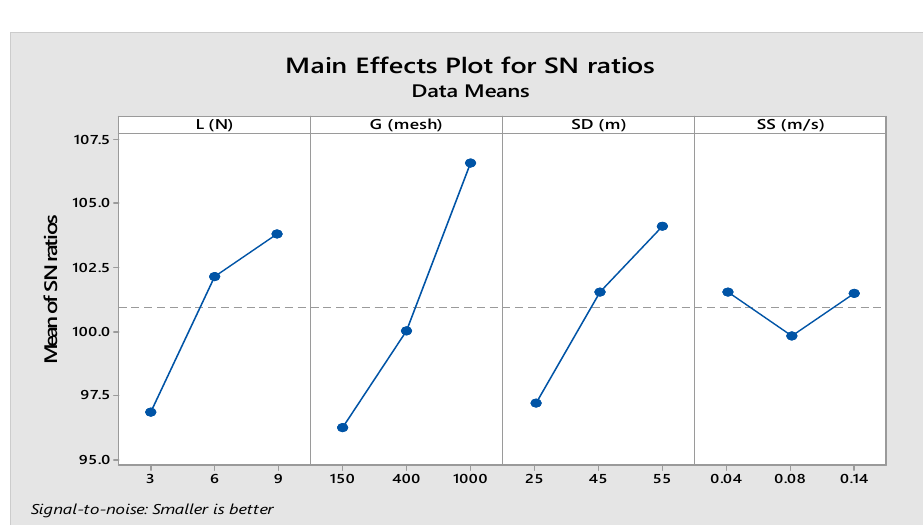
Figure 14. Main effect plot for SNRs of T s .